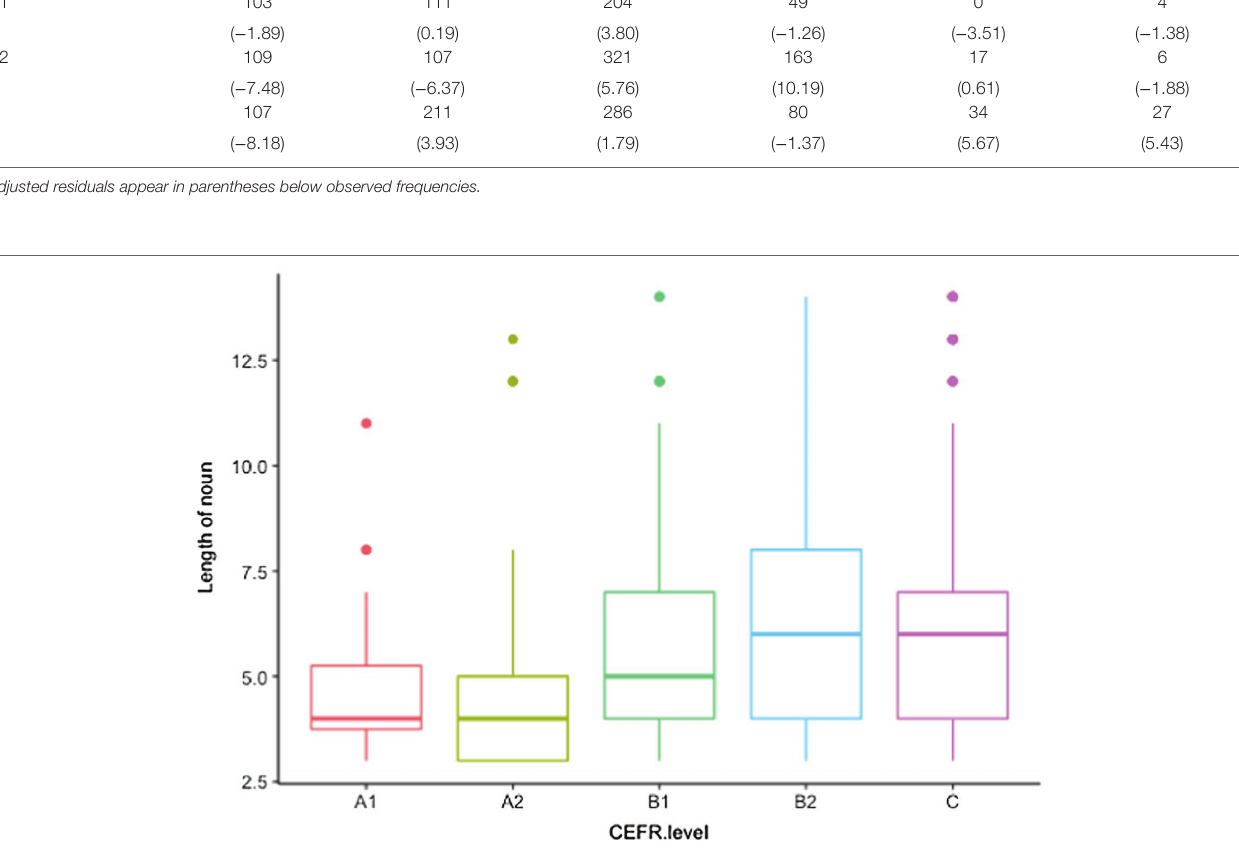
FIGURE 3 | The relationship between the CEFR level and length of noun